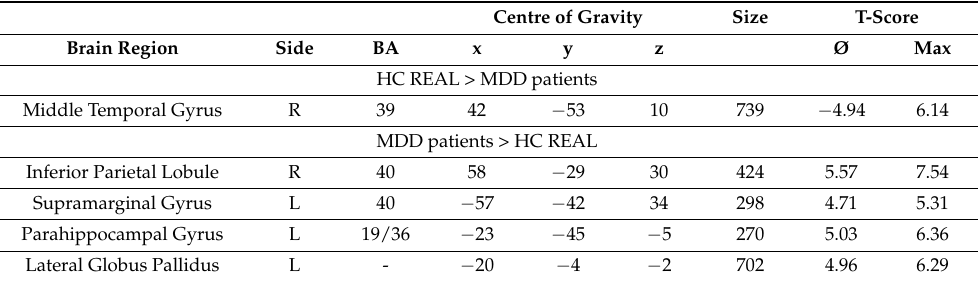
Table 10. Hemodynamic responses between the first and the last NF run (negative emotion-associated pictures minus neutral pictures; clusters of >30 voxels, q (FDR) < 0.001, T-score: 8 to − 8). Centre of